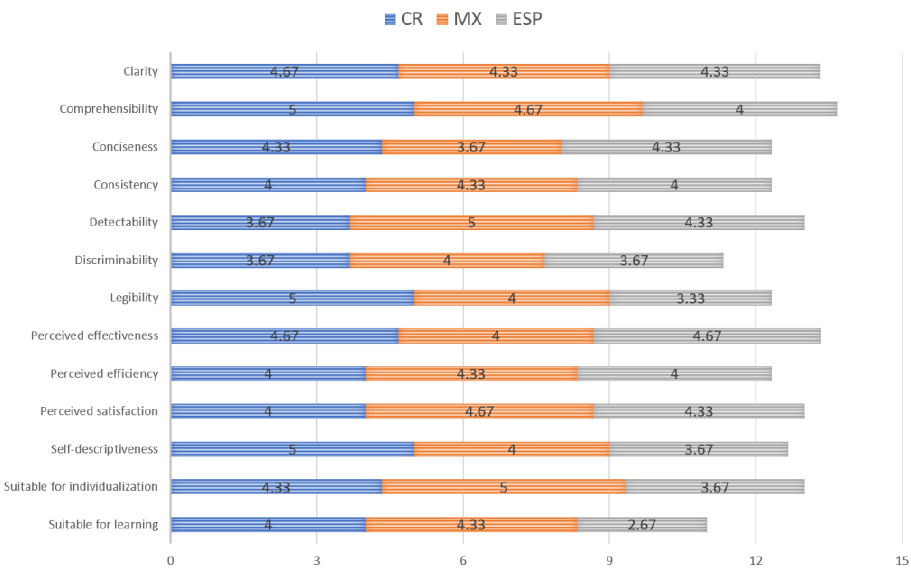
Figure 7. Evaluation of system characteristics based on the standard ISO 9241-210:2010. Table 4. Minimum, maximum, quartiles and reliability analysis for Likert scales depicted in Figure